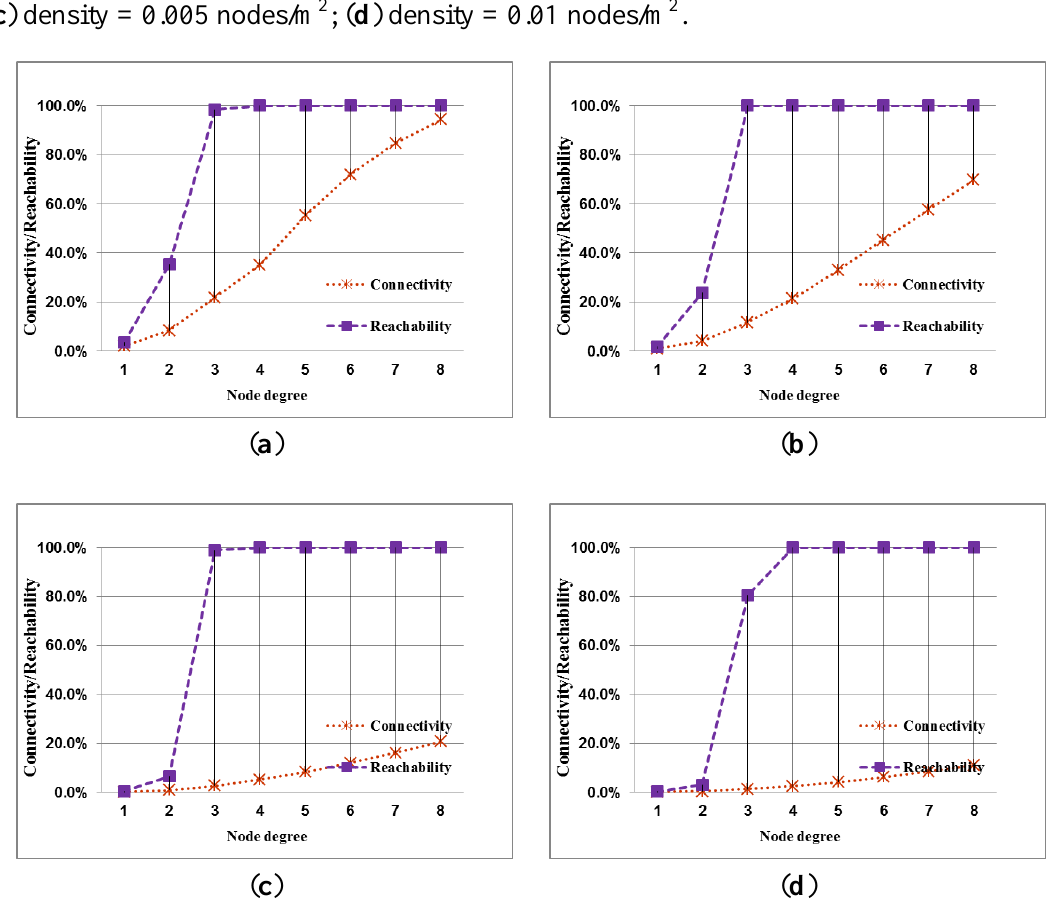
Figure 6. A comparison of the simulation results for connectivity and reachability with different node densities.( a ) density = 0.0005 nodes/m 2 ; ( b ) density = 0.001 nodes/m 2